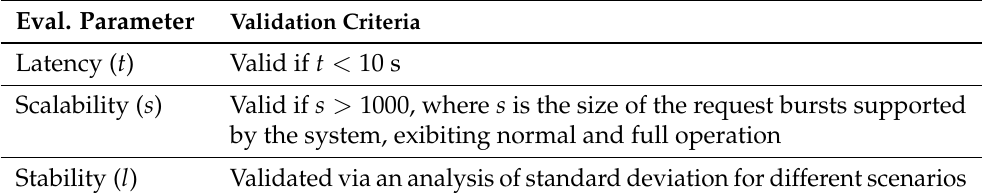
Table 3. Selected evaluation